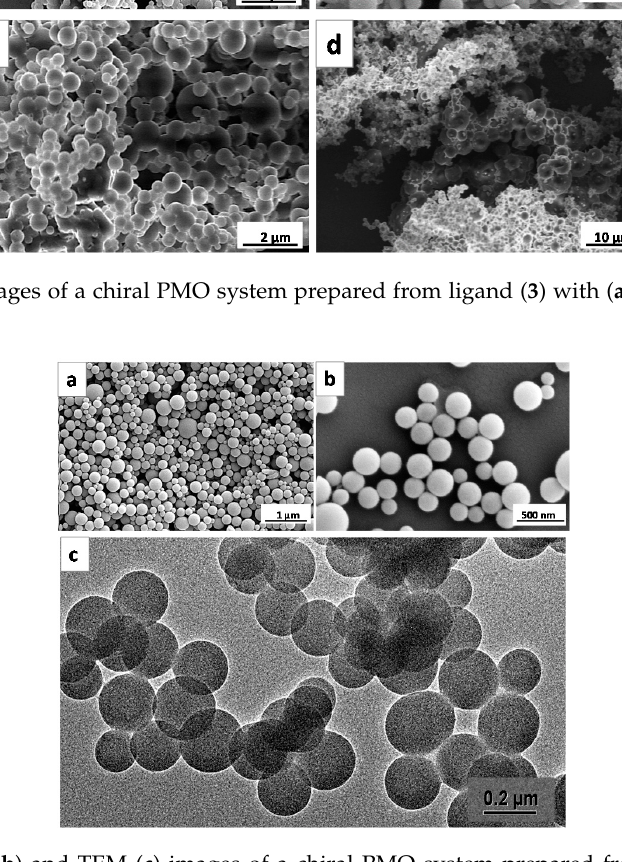
Figure 4. SEM ( a , b ) and TEM ( c ) images of a chiral PMO system prepared from ligand ( 4 ) with CTAB surfactant.